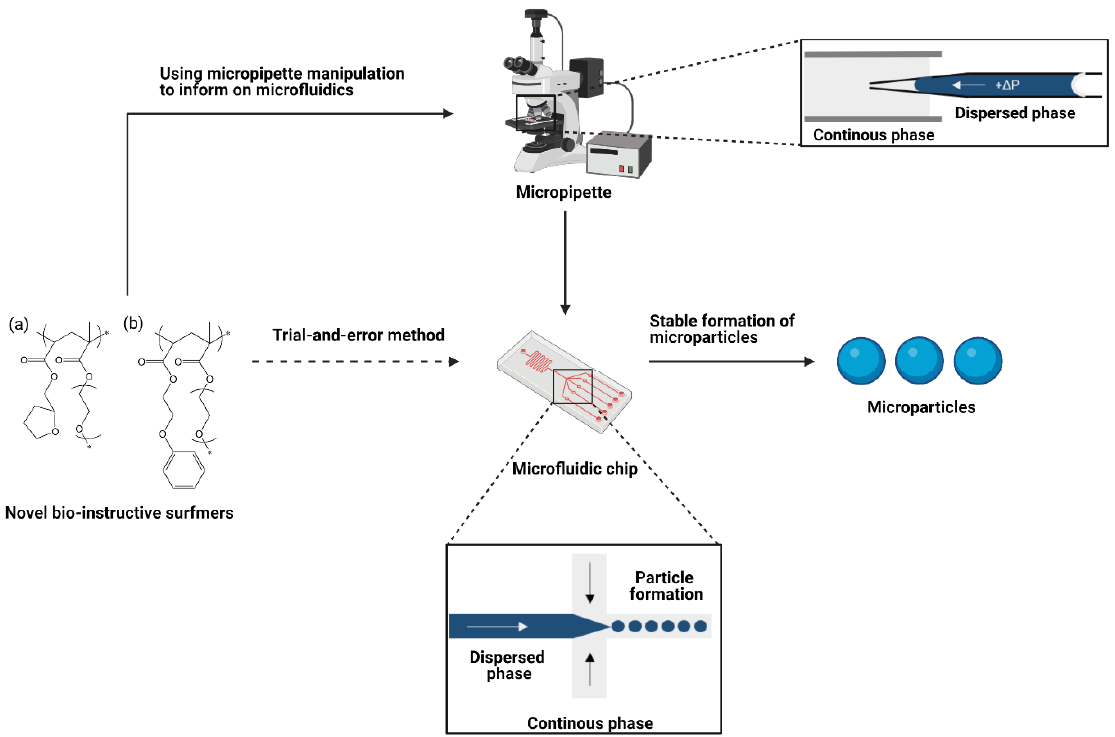
Figure 1. Particle formation with novel surfactants often requires lengthy optimisation if trial-and-error approaches are used. Using micropipette manipulation methods to inform droplet microfluidics removes this problem while providing detailed information about the system. The setup within the micropipette mirrors exactly that of the flow-focusing microfluidics chip so the information gained can be transferred directly. Polymeric surfactants used are ( a ) THFuA-co-mPEGMA and ( b ) EGPEA-co-mPEGMA in the dispersed phase with poly( D , L -lactic acid) (PDLLA) in ethyl acetate. The continuous phase is MilliQ water with, or without, poly(vinyl acetate-co-alcohol) (PVA). Figure created with BioRender.com.